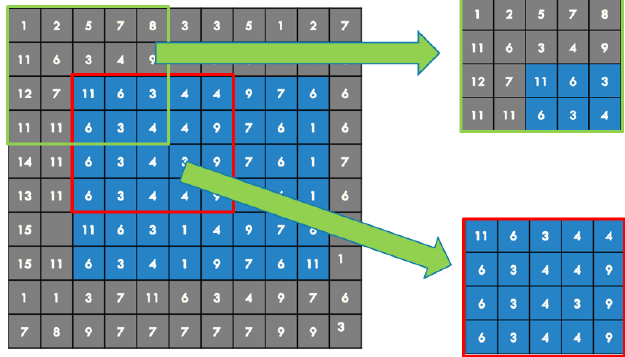
Figure 6. Illustration of Clipping Attack Countermeasures.